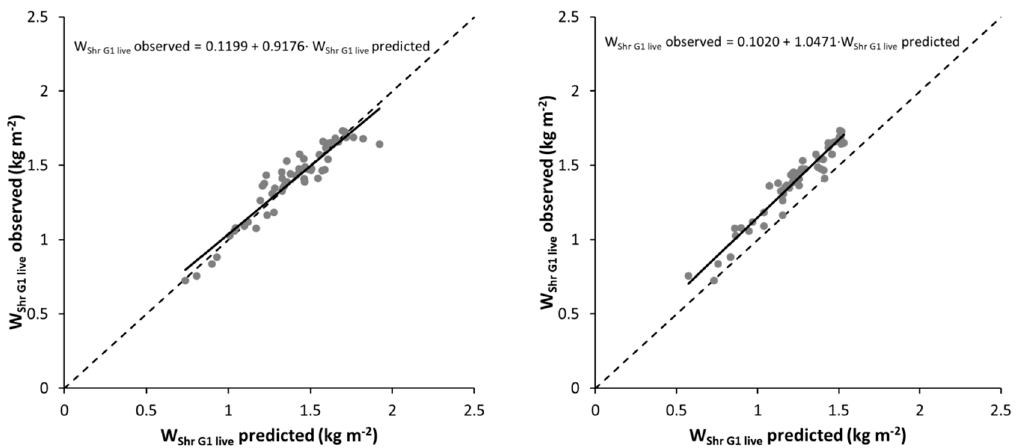
Figure 3. Plots of observed versus predicted values of shrub and litter fuel load ( W Shr + Litt ), total shrub fuel load ( W Shr ), litter fuel load ( W Litt ), coarse shrub fuel load ( W Shr_G 23 ), fine shrub fuel load ( W Shr_G 1 ), dead fine shrub fuel load ( W Shr_G 1_ dead ), and live fine shrub fuel load ( W Shr_G 1_ live ) for DE (left) and IE (right) approaches. Table 5. Final expression of the equations fitted to estimate the inputs of the biomass equations developed for the shrub communities in Galicia [69] from usual field measurements, with TLS-based metrics, the parameter estimates, the approximate standard errors and the goodness-of-fit statistics. Cov Shr = shrub cover (%), h Shr = mean shrub height and d Litt = mean litter depth. Variable Expression Par. Estimate Approx. Std.